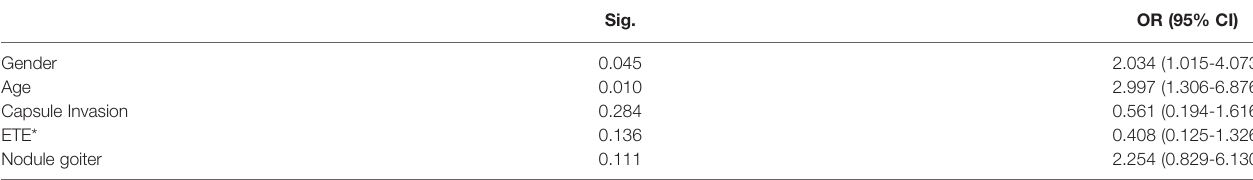
TABLE 2 | Multivariate analysis of the risk factors of PTC.